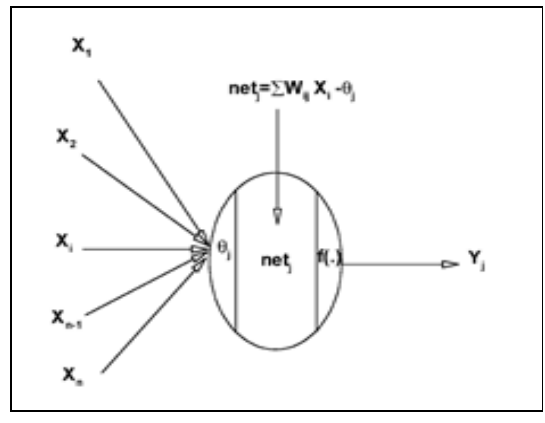
Figure 1 An Artificial Neuron Symbols (T.L. Lee, 2002)